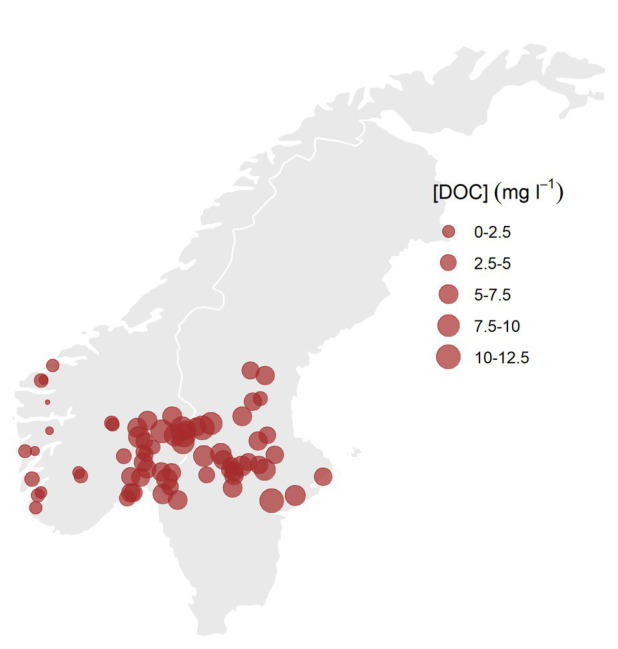
Map of the survey lakes, the size of the circles indicates the concentrations of dissolved organic carbon (DOC; mg L−1).